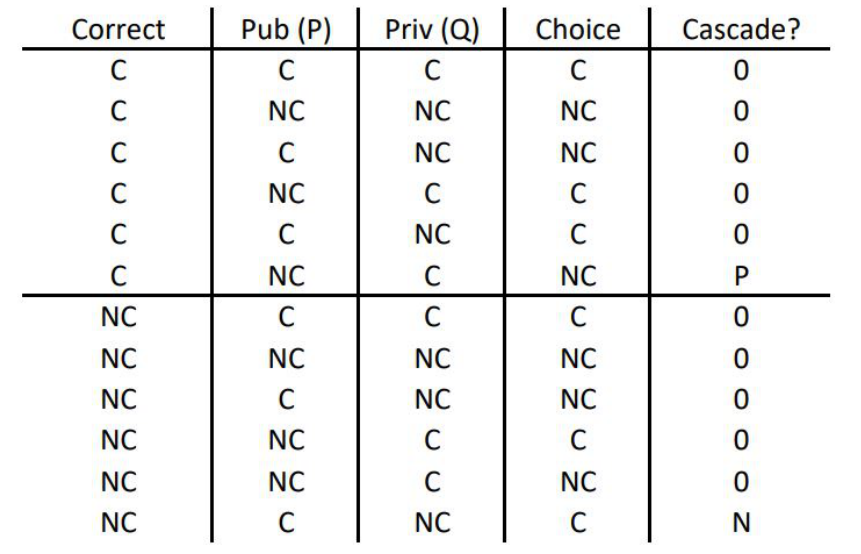
Figure 3. Truth table for determining which combination of choices made by nodes are considered as contributing to cascades. The first column indicates whether the choice to connect (C) or not connect (NC) is correct. The second and third columns show the indications from public and private information. The forth column is the actual choice made by the newcomer. The fifth column indicates if a cascade has occurred, either P or N cascade, or if none has occurred with 0.